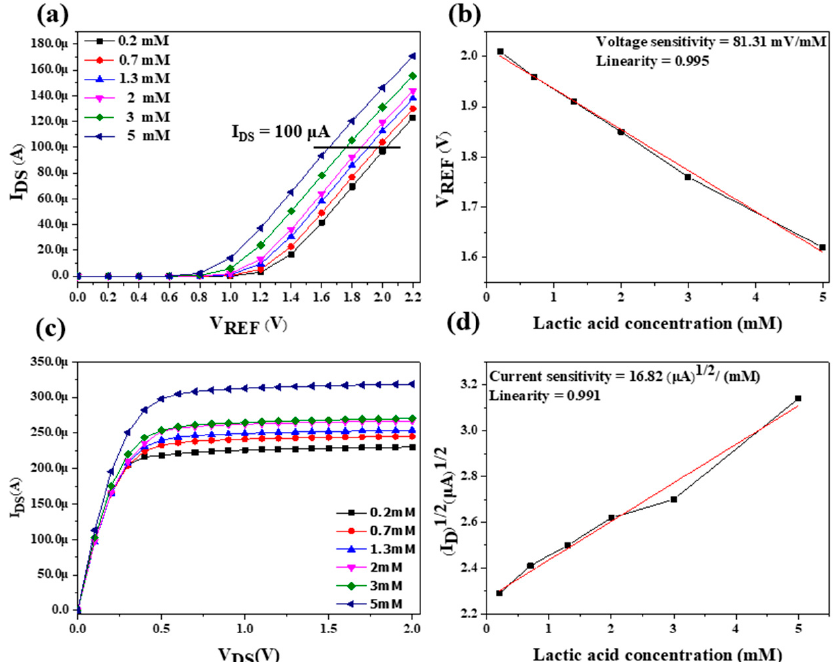
Figure 9. The sensing characteristics of EGFET for LA detection under the static measurement. ( a ) I DS –V REF conversion curve, ( b ) voltage sensitivity when I DS = 80 μ A, ( c ) I DS –V DS transfer curve, and ( d ) current sensitivity.